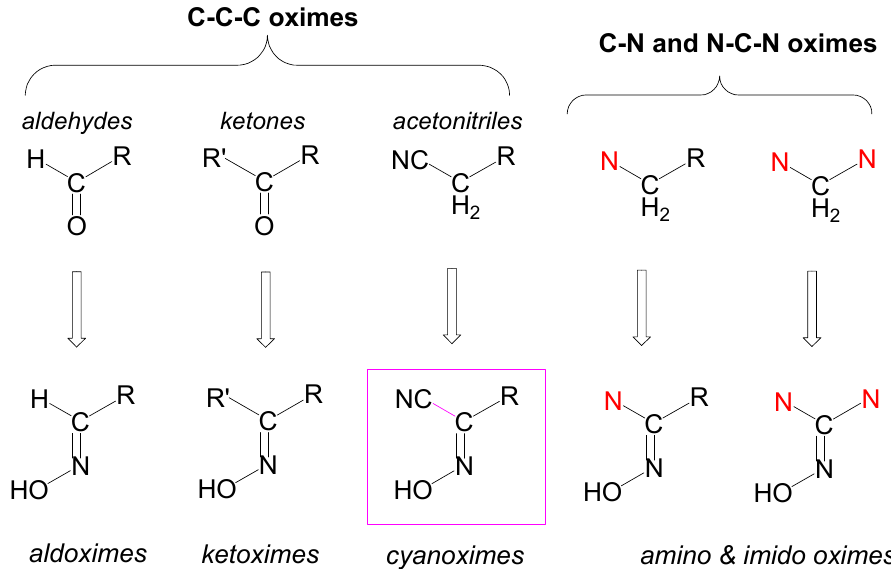
Figure 1. Types of oximes and their precursors.